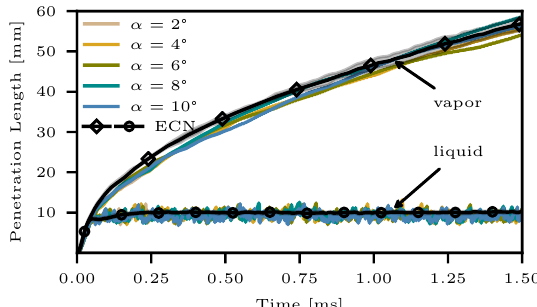
Figure A1. Liquid and vapor penetration for cases with varied half cone angle ( α ) of the spray. Results are compared with ECN data, wherein the filled region denotes experimental uncertainty. Spray sub-models follow those in cases